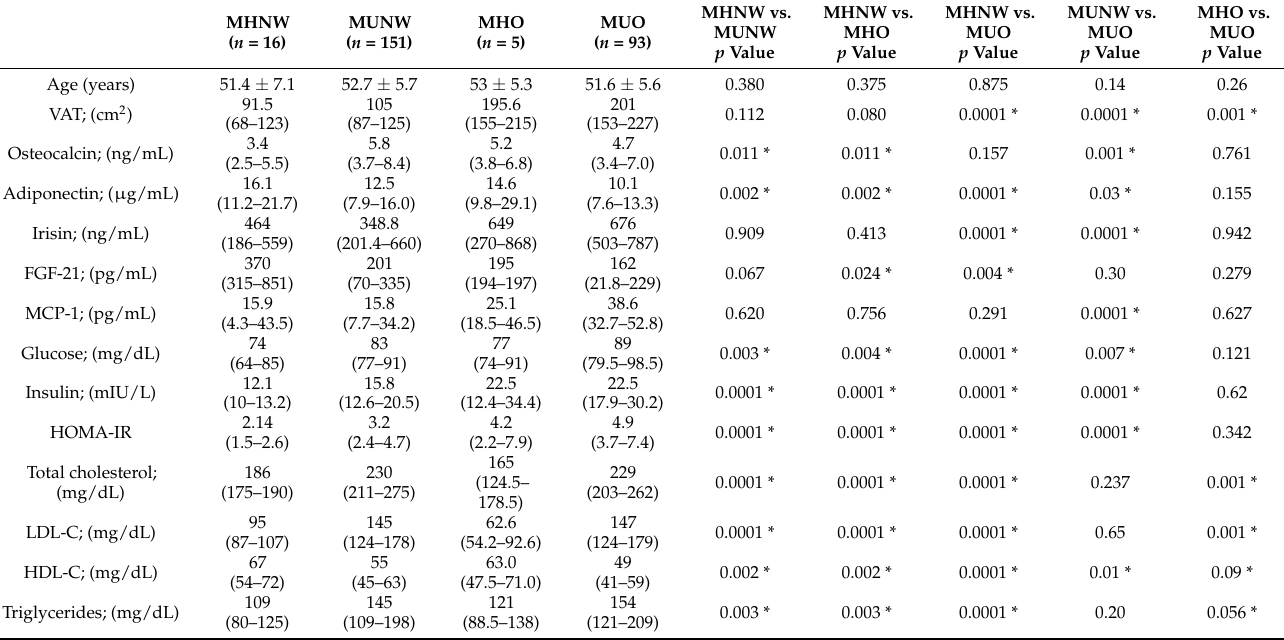
Table 2. Clinical and biochemical characteristics according to the body size phenotype in middle-aged